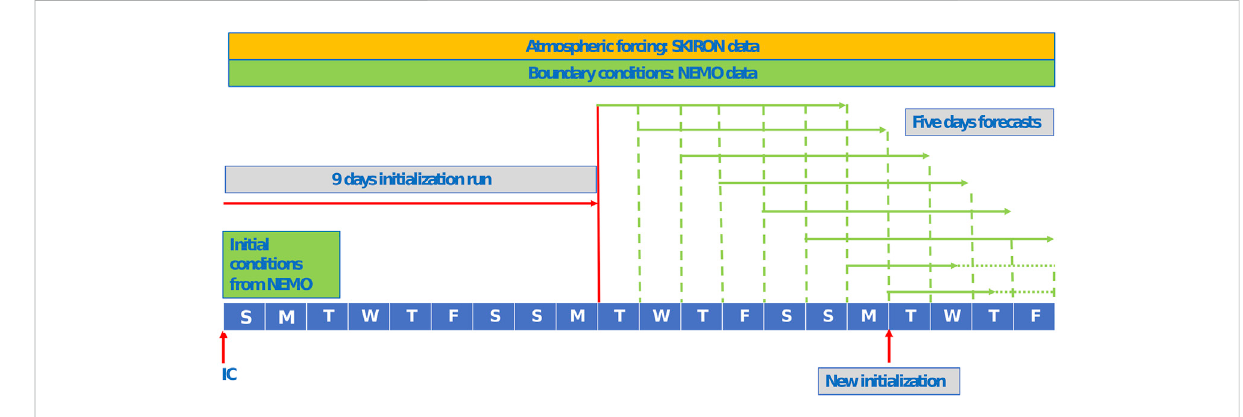
FIGURE 1 MITO operational chain.